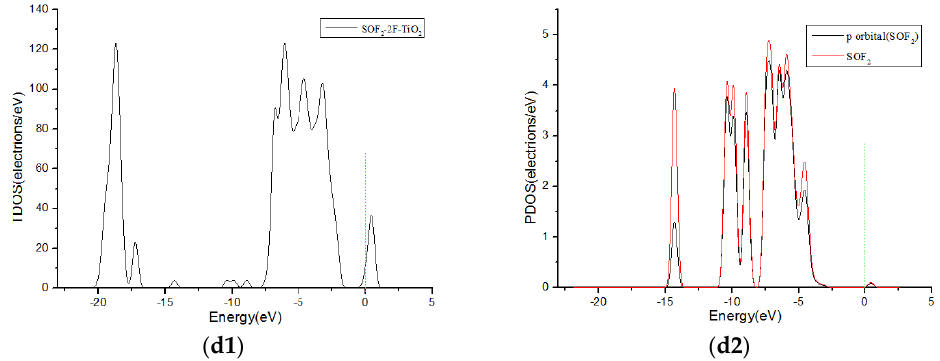
Figure 7. TDOS and PDOS of SOF 2 molecules adsorbed onto F-doped TiO 2 , and the green short dashed line is Fermi level. ( a1 , a2 ) are the TDOS and PDOS of SOF 2 -S-TiO 2 , ( b1 , b2 ) are the TDOS and PDOS of SOF 2 -O-TiO 2 ,( c1 , c2 ) are the TDOS and PDOS of SOF 2 -F-TiO 2 , ( d1 , d2 ) are the TDOS and PDOS of SOF 2 -2F-TiO 2 .